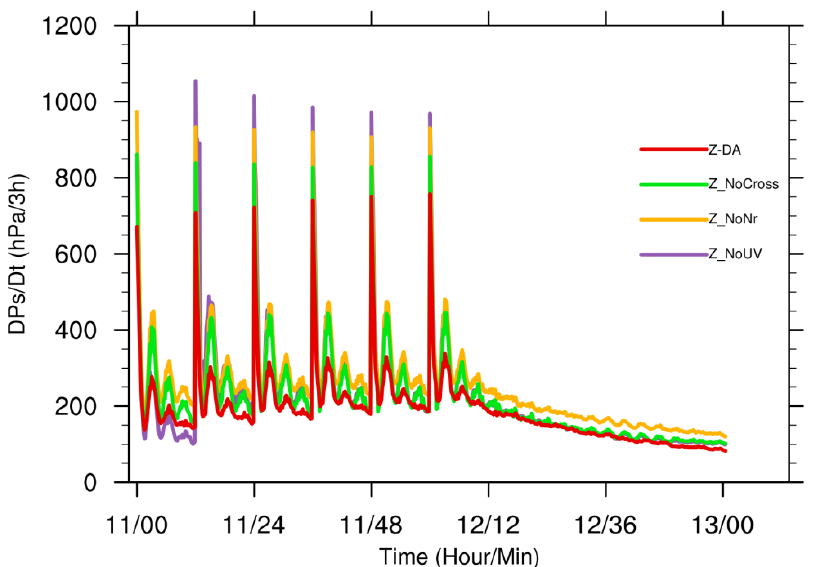
Figure 8. Mean absolute pressure tendency during the five DA cycles and the first 1 h forecast for the four DA sensitivity experiments.